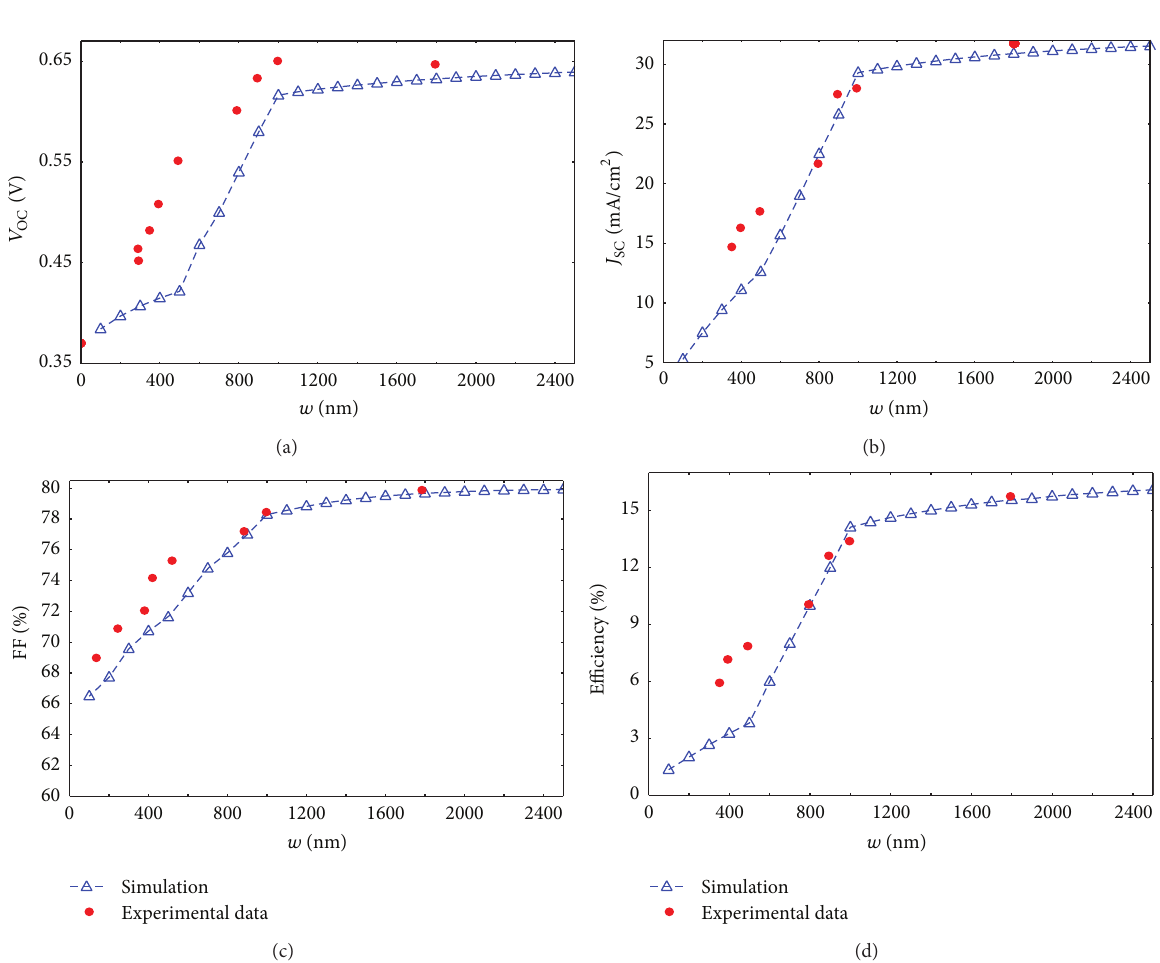
), open-circuit voltage ( 𝑉 ), fill factor (FF), and the efficiency. sc oc